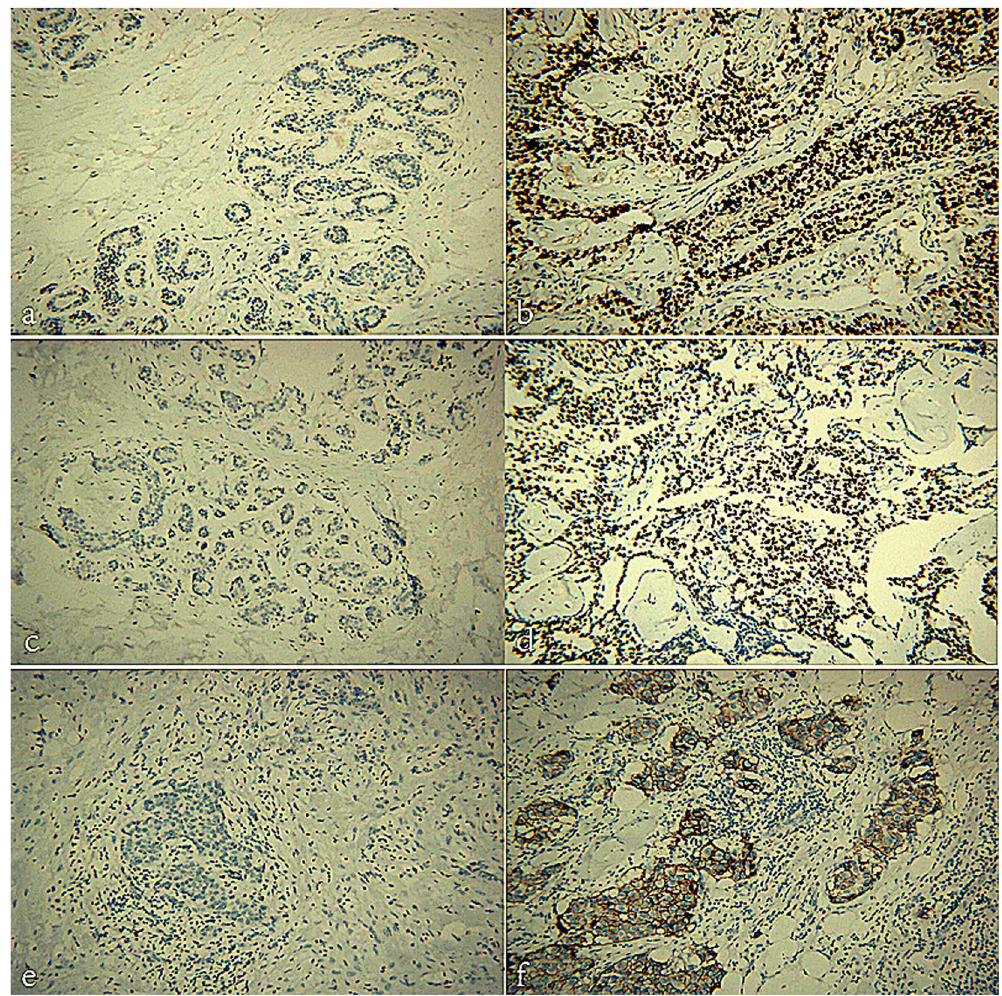
Figure 4. Representative immunohistochemical staining of estrogen receptor (ER), progesterone receptor (PR), and C-erbB-2. ( a ) ER status (negative); ( b ) ER status (positive); ( c ) PR status (negative); ( d ) PR status (positive); ( e ) C-erbB-2 expression (negative); and ( f ) C-erbB-2 expression